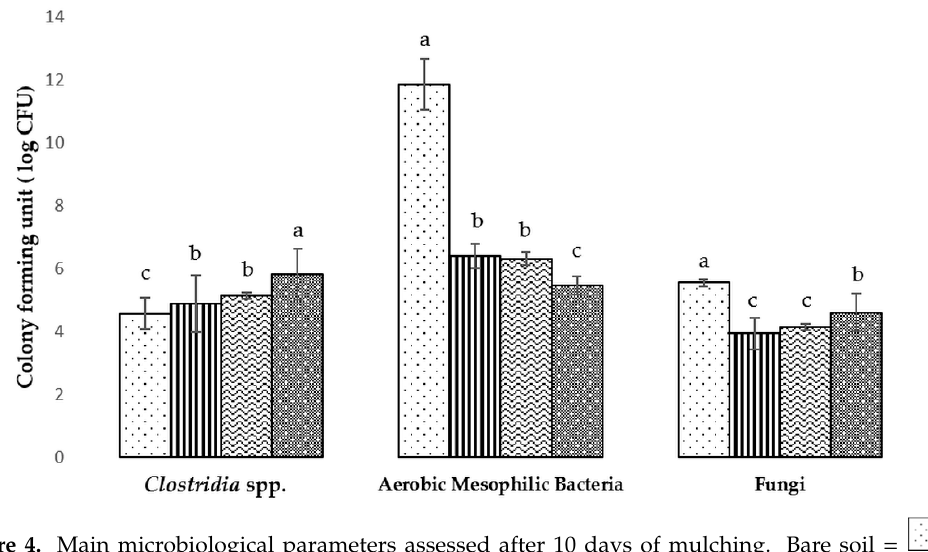
Figure 4. Main microbiological parameters assessed after 10 days of mulching. Bare soil = ; Mater- Bi = ; protein-based film from black soldier fly prepupae = ; polyethylene = . Whiskers indicate the standard deviation interval, while bars with the same letter do not significantly differ at p < 0.05. The statistical differences were tested only between the different treatments at each time point.